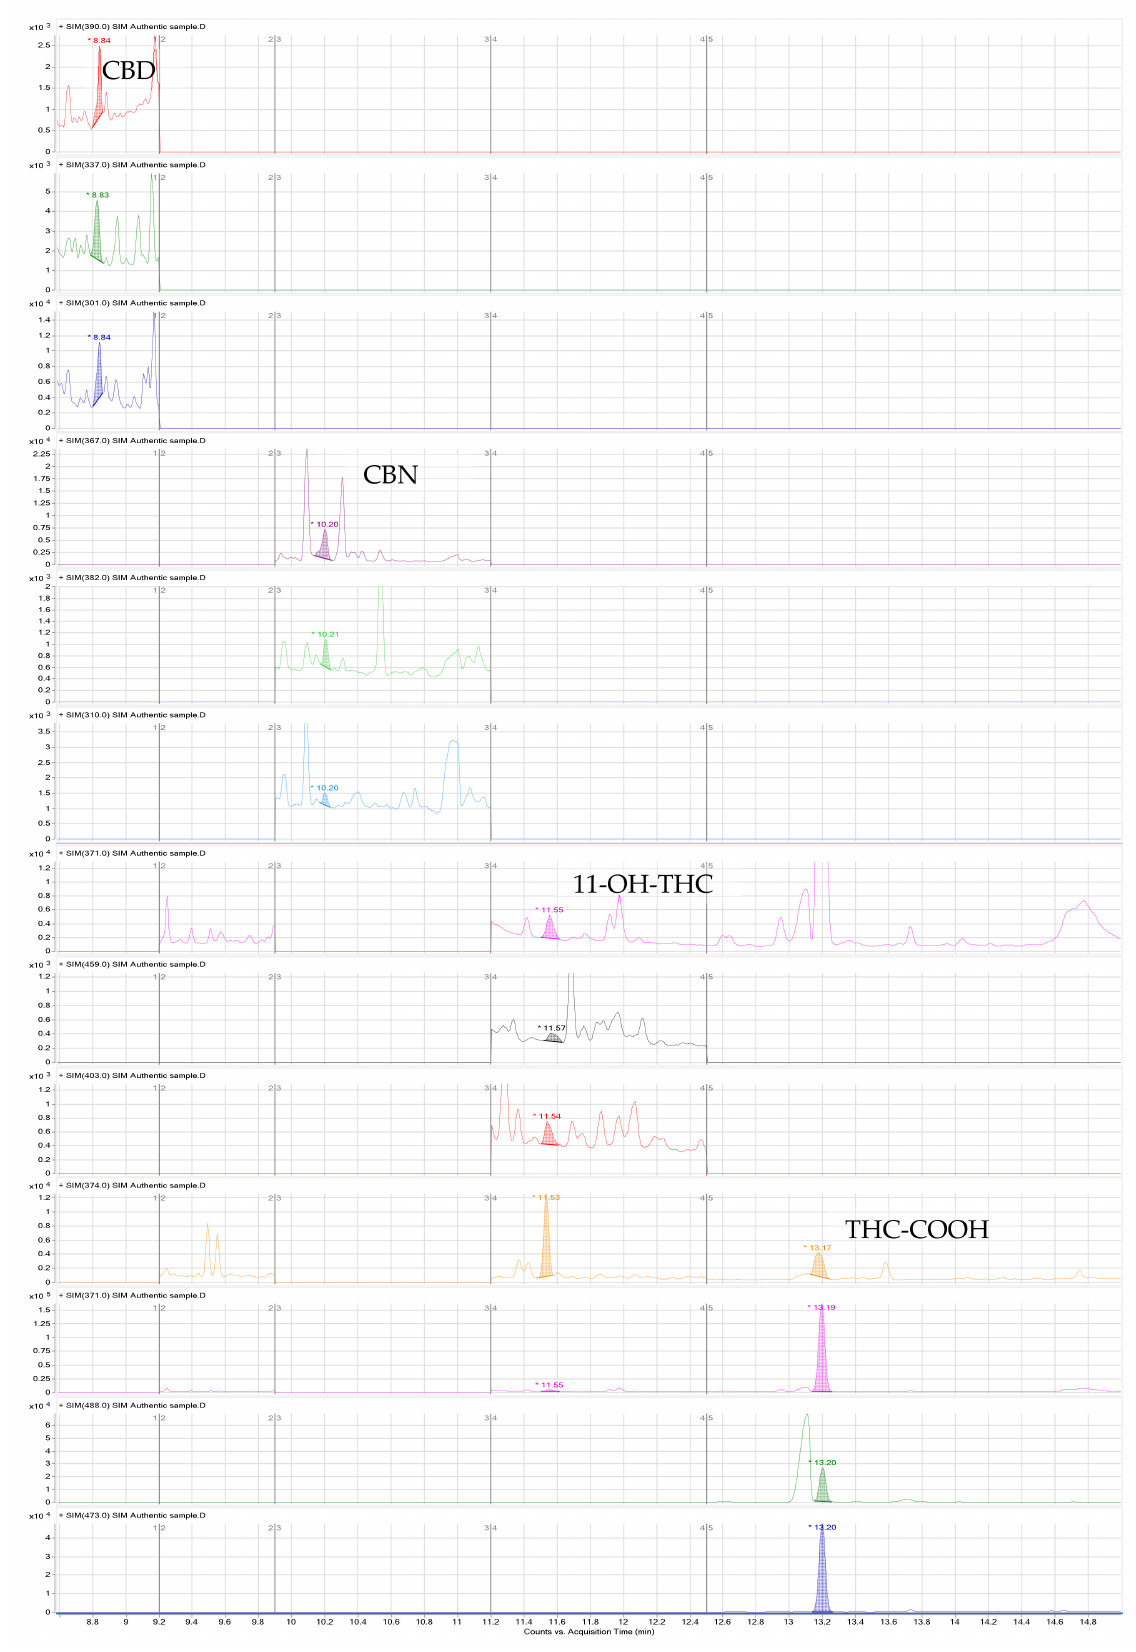
Figure 6. Chromatogram of an authentic sample (number 6 in Table